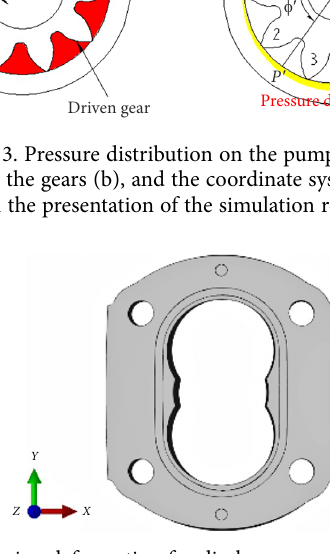
Figure 4. Casing deformation for discharge pressure of 32 MPa (deformation scale factor: